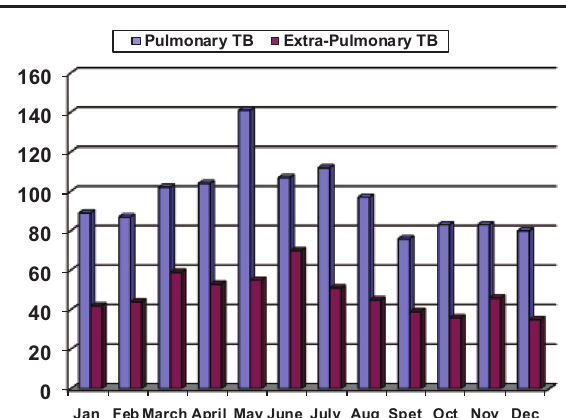
Table 3 Sociodemographic characteristics of the studied